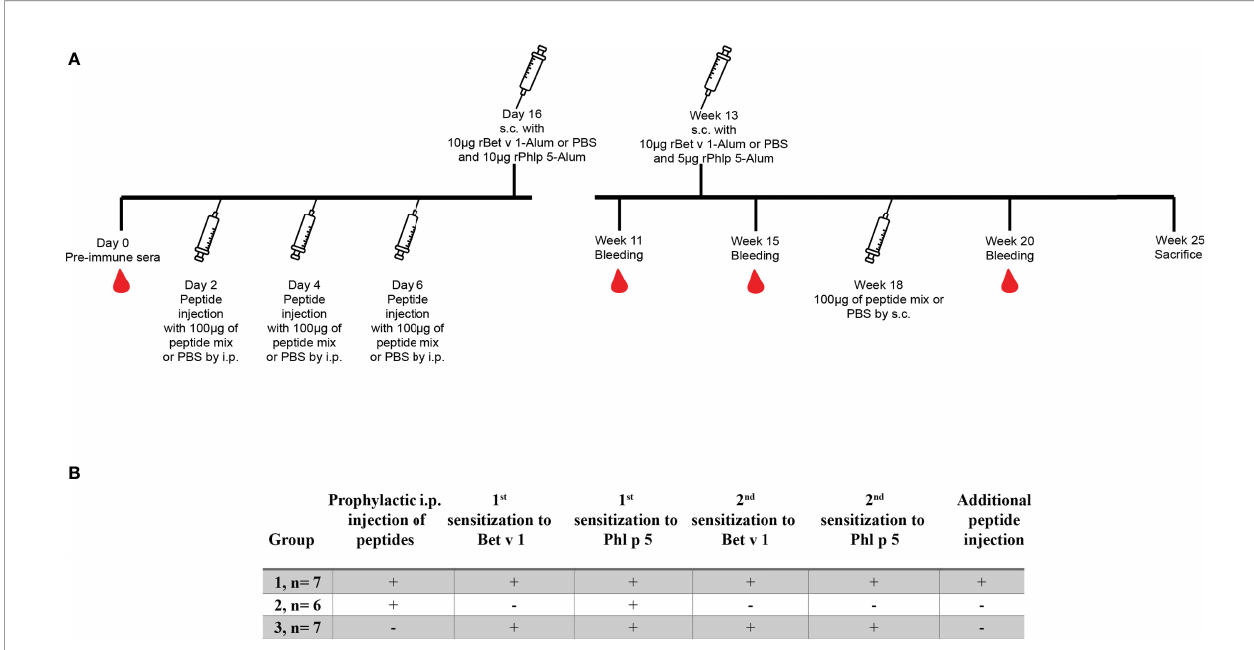
FIGURE 1 | Scheme for fi rst preventive treatment with Bet v 1-derived peptides. (A) Three to four week old female BALB/c mice received 3 i.p. injections of a 100µg mix of Bet v 1-derived peptides or PBS followed by two s.c. sensitisations with 10µg of either rBet v 1 or PBS and 10µg of an unrelated control allergen, rPhl p 5, adsorbed to Al(OH) 3 at the indicated time points. Thereafter, mice received another injection of the peptide mix or PBS. Time points of injections, bleeding, and sacri fi ce are indicated. (B) Characteristics of the 3 mouse